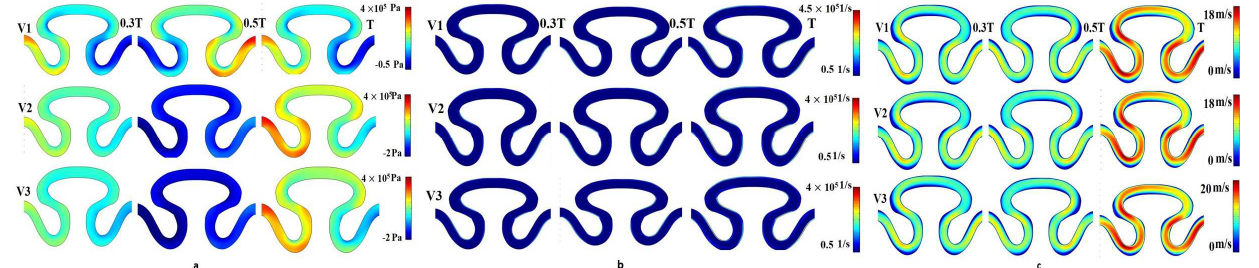
Figure 6. Contour Plot of ( a ) pressure, ( b ) shear rate, ( c ) axial velocity, ( d ) wall stress for sinusoidal flow, slip wall boundary condition for velocity models V 1 , V 2 and V 3 . For the sinusoidal flow with no-slip wall boundary condition (condition II), local minimal variation in pressure, shear rate, and axial velocity were analyzed for velocity models V 1 , V 2 , and V 3 (Figure 7). A significant variation of pressure distribution was recorded for velocity model V 1 compared to the two other velocity models. For velocity models V 2 and V 3 , the local maximum pressure equal to 4 × 10 5 Pa was observed in the neck region (P 1 ) of the channel at end of cycle time T, as shown in Figure 7a. Maximum pressure was generated at the time T/2 sec in the periphery of the rear region (P 2 ). It was noticed that the value of axial velocity was similar for V 1 , V 2 , and V 3 velocity models. The maximum velocity was generated at the end of the T cycle for all inlet velocity models. The minimum and maximum axial velocities were observed as 0 and 20 mm/min, respectively, in the neck region (P 1 ) and periphery of the rear region (P 3 ), as shown in Figure 7c. Negligible variation had been observed in the shear rate for different velocity models in all regions of the serpentine at T/3, T/2, and T sec. The shear rate profiles for velocity models V 1 , V 2 , and V 3 were similar and its range of magnitude was 0.5–4.5 × 10 5 1/s, as shown in Figure 7b.